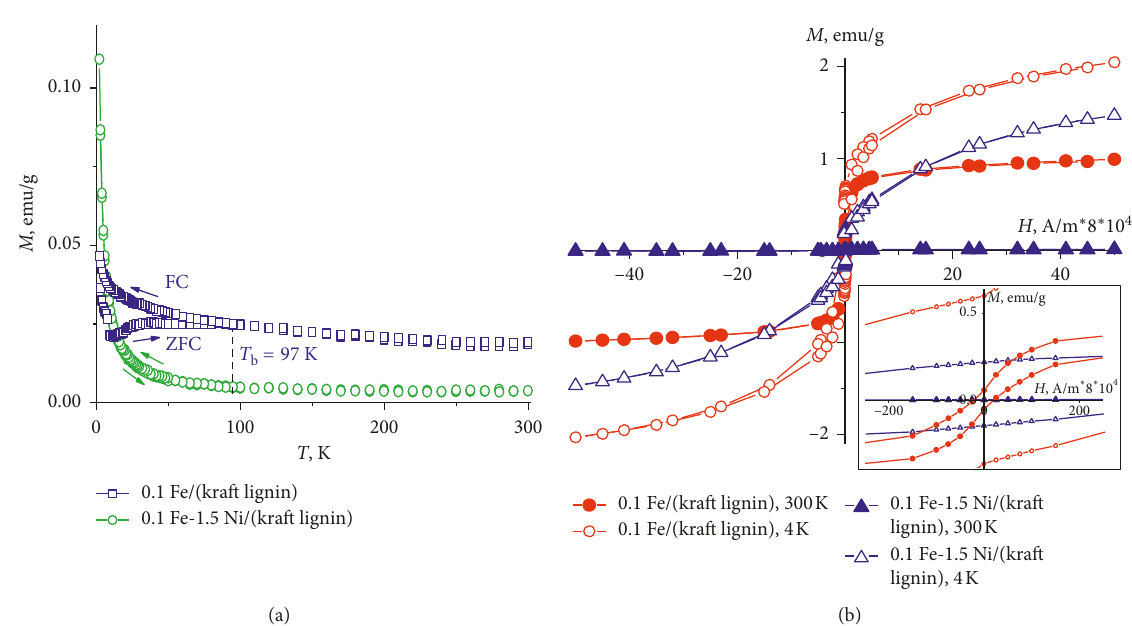
Figure 5: ( a ) Temperature dependence of the magnetization ( N ) in a H � 39.8kA/m field for initial (before the reforming) of samples 0.1 Fe/(kraft lignin) ( ○ ) and 0.1 Fe-1.5 Ni/(kraft lignin) ( □ ) recorded in the FC and ZFC modes. The inset shows the N ( T ) curves for samples 3, 6, and 7 measured in a H � 39.8kA/m field; (b) M(H) curves for samples 3 and 6 at T � 300 and 4 K after the reforming. The inset shows the hysteresis loops for low fields at T � 300 and 4K (residual N r � 0.6 emu/g and N r � 0.06 emu/g for 4 and 300K, respectively; saturation � 1.51emu/g and N � 0.84 emu/g for 4 and 300K, N s s